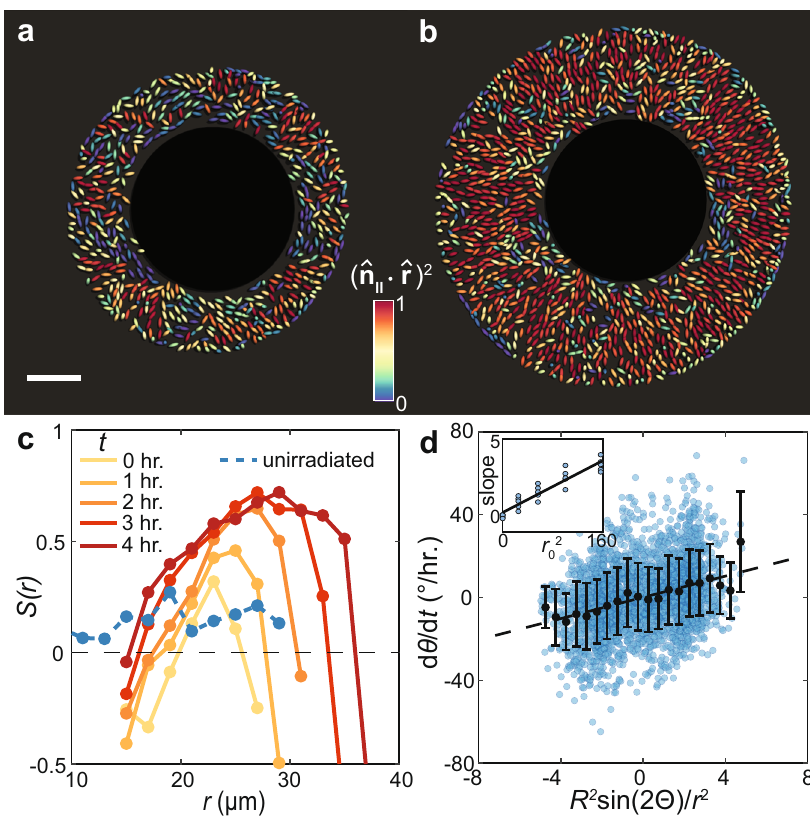
Fig. 3 Cell organization can be manipulated by controlling spatial growth patterns. a , b A nonadherent bio fi lm grown for 17 h was irradiated using 405 nm laser to induce cell death in a circle of radius 15 μ m at the center. Colors denote the degree of radial alignment of individual cells ^ n (cid:2) ^ r ( a ) and 4 hours ( b ) after irradiation. c S ð r Þ in the irradiated bio fi lm (colored according to time) and the unirradiated control (blue). d Angular velocity of individual cells from ABSs with a growth void plotted against the predicted nondimensionalized driving force (superimposed error-bars correspond to the mean ± s.d. of the data binned on 0.5-unit intervals; n (cid:5) 6 cells per bin). Inset: fi tted slope from ( d ) for different growth void sizes r 0 ( μ m 2 ). Source data are provided as a Source Data fi